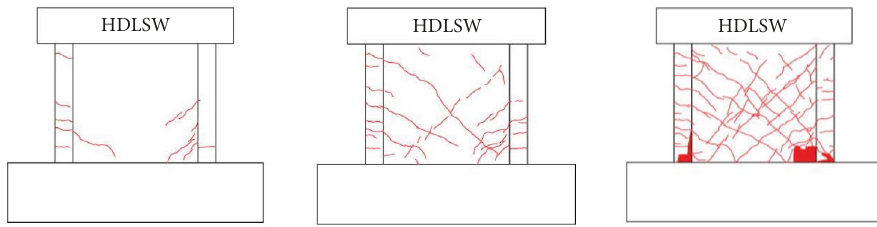
Figure 7: Crack development of the shear wall